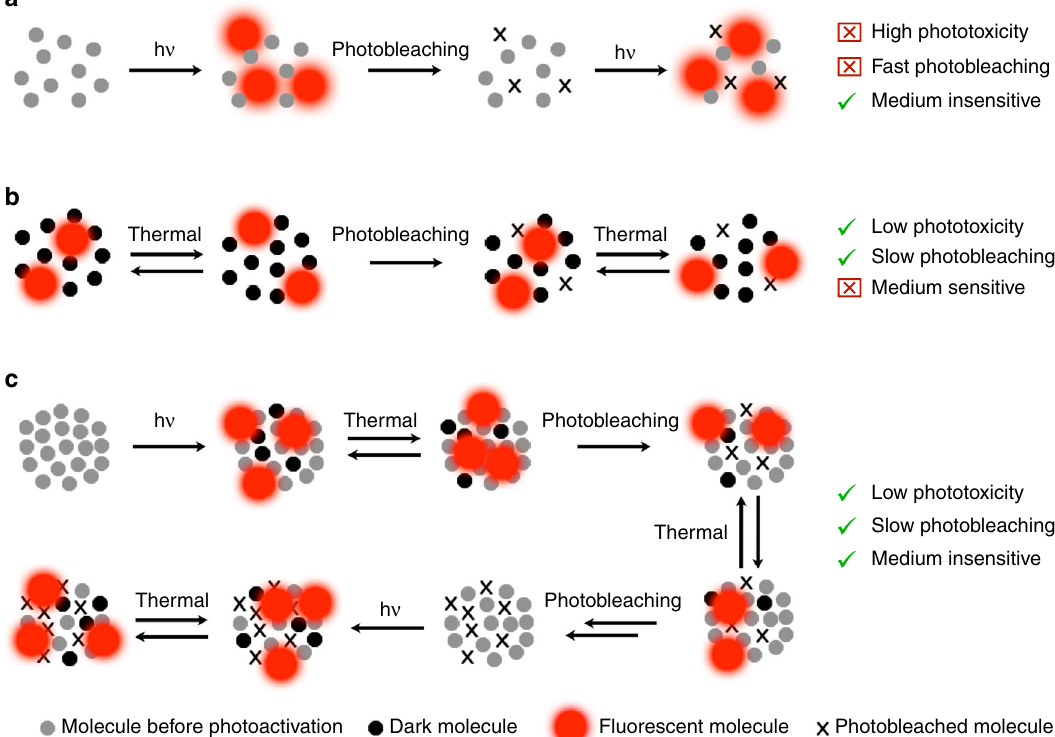
Fig. 1 Mechanisms of single-molecule localization. a Classical mechanism employing photoactivatable dyes. b Spontaneously blinking dyes in a low-polarity environment (e.g., membranes). c Photoregulated fl uxional fl uorophores reported in this